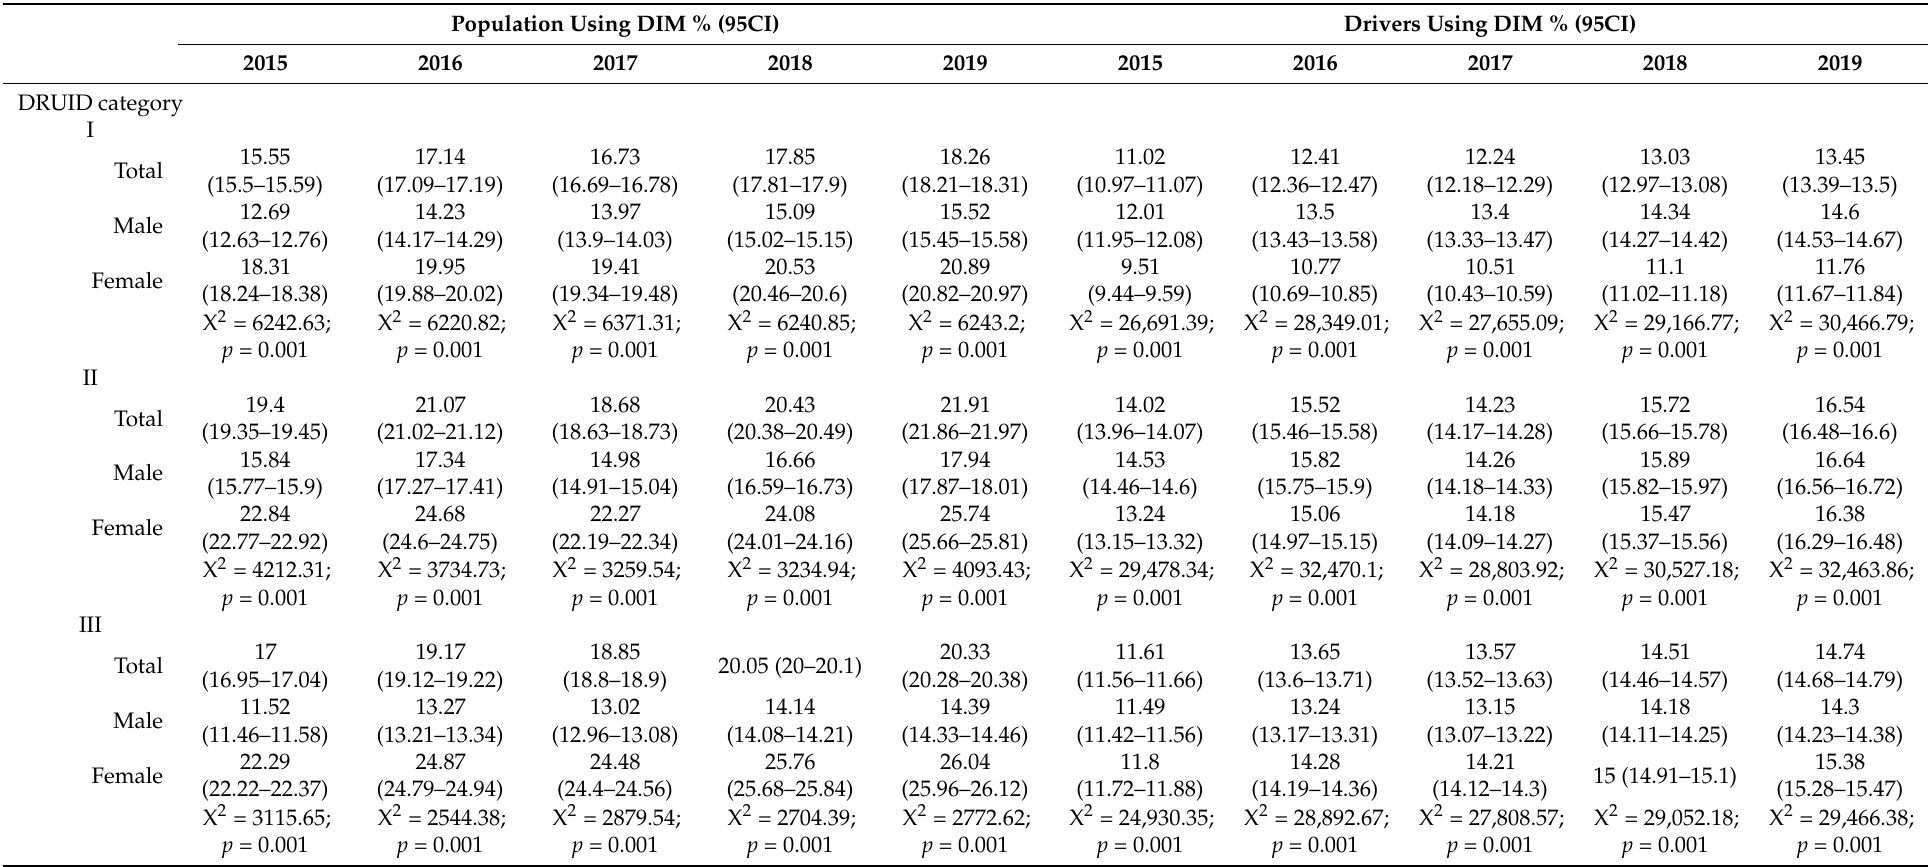
Table 2. Evolution of the use of DIMs according to CONCYLIA database and the Castile and Le ó n drivers’ license census data